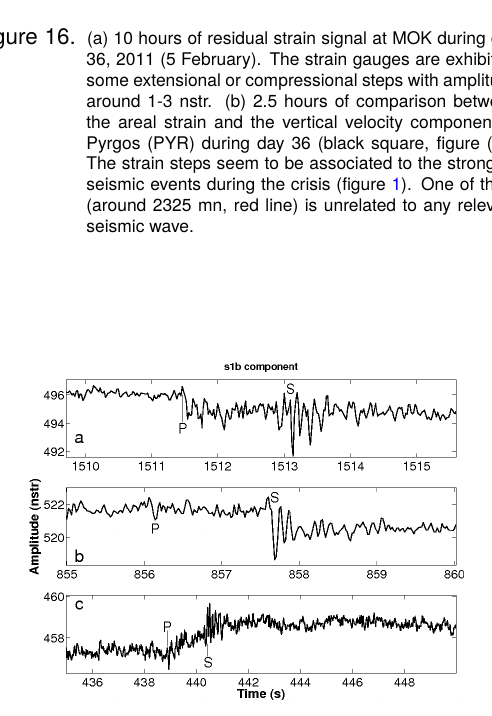
Figure 17. Example of strain variation at MOK on s1b component duringseismicepisodesofday36,2011(5February): (a) step after P-wave arrivals, (b) step after S-wave arrivals, (c) gradual deformation between P and S waves. In each case, the related amplitudes are around 1-3